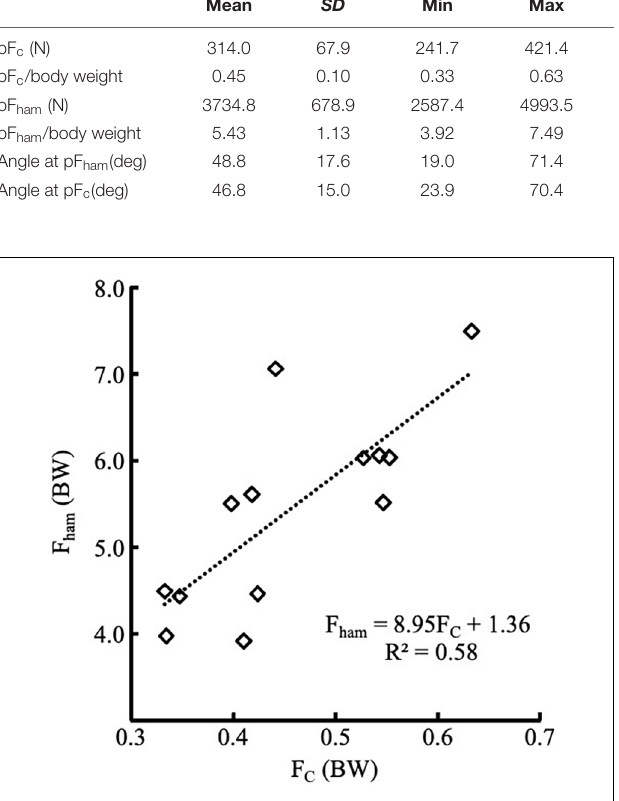
FIGURE 3 | Linear positive relationships between body weight normalized F c and F ham ( p < 0.01). F ham = 8.95*F c +1.36, r 2 = 0.58.